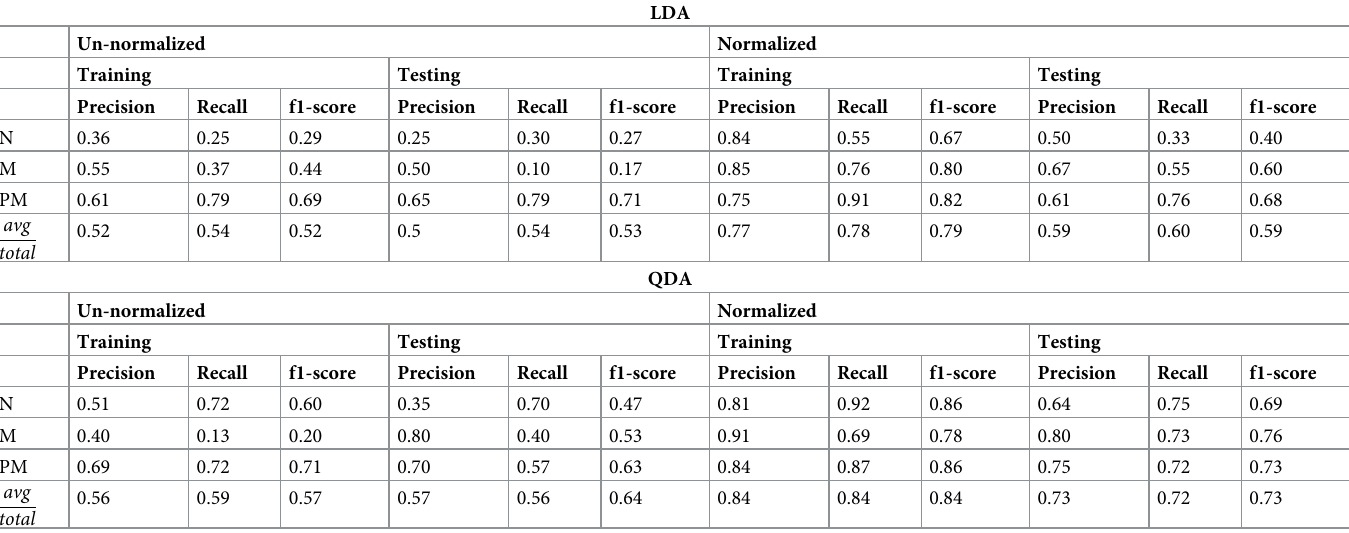
Table 6. Performance table of buccal